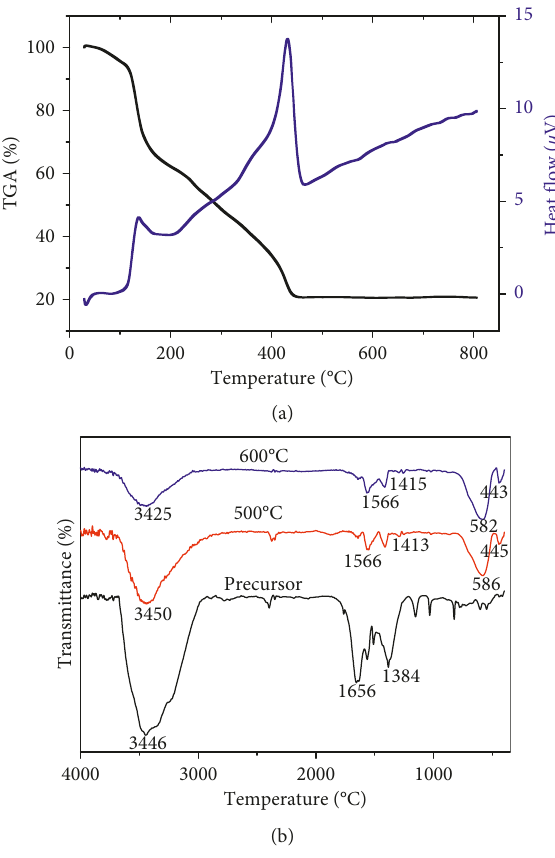
Figure 1: TGA/DTA curve of the precursor (a) and FT-IR spectra of the precursor and MgFe 2 O 4 calcined samples at 500–600 ° C (b).